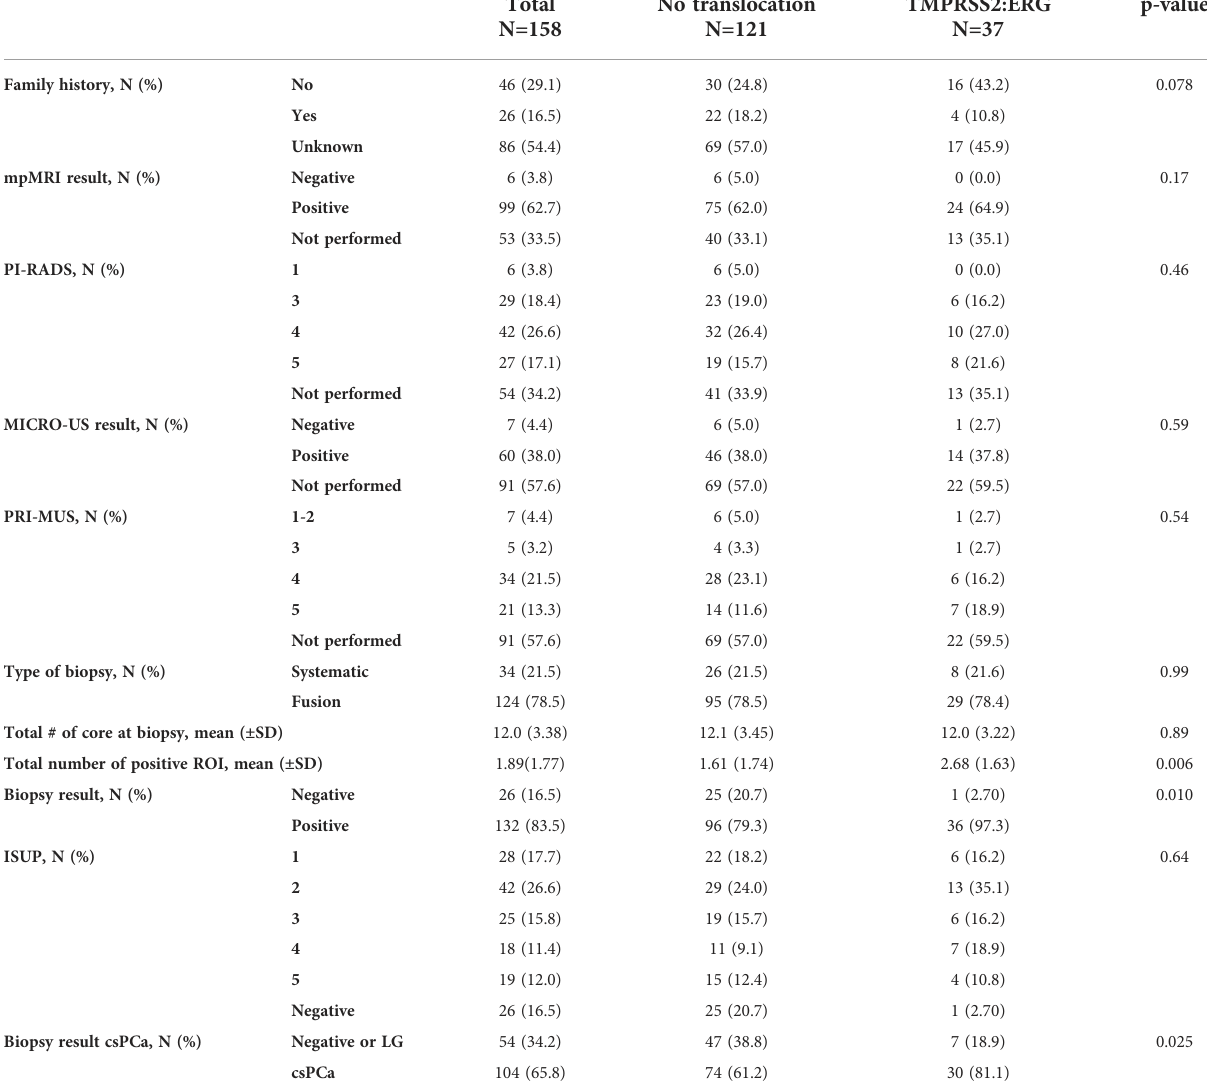
TABLE 2 Imaging and biopsy fi ndings by absence or presence of T2:ERG